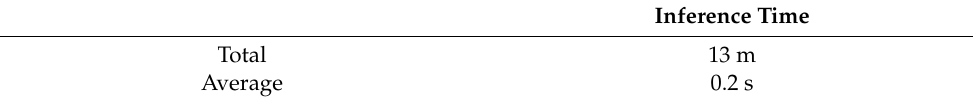
Table 14. Test Inference